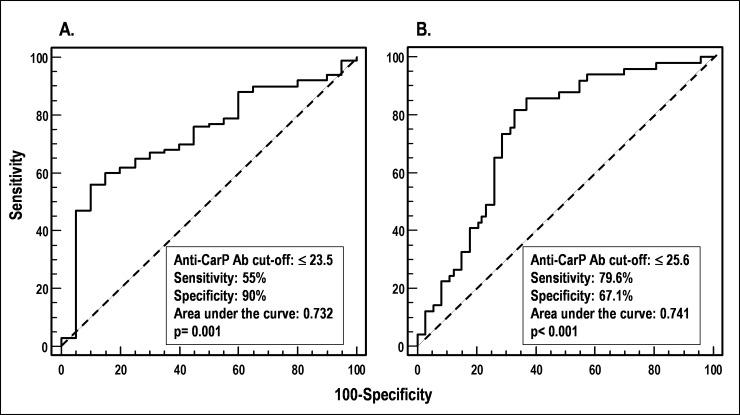
Receiver operating characteristic (ROC) analysis to define levels of anti-CarP Ab (cut-offs) that distinguish patients according to clinical variables.(A) SSc patients with mRss>0 vs those with mRss = 0. (B) SSc patients with scleredema vs those without it.